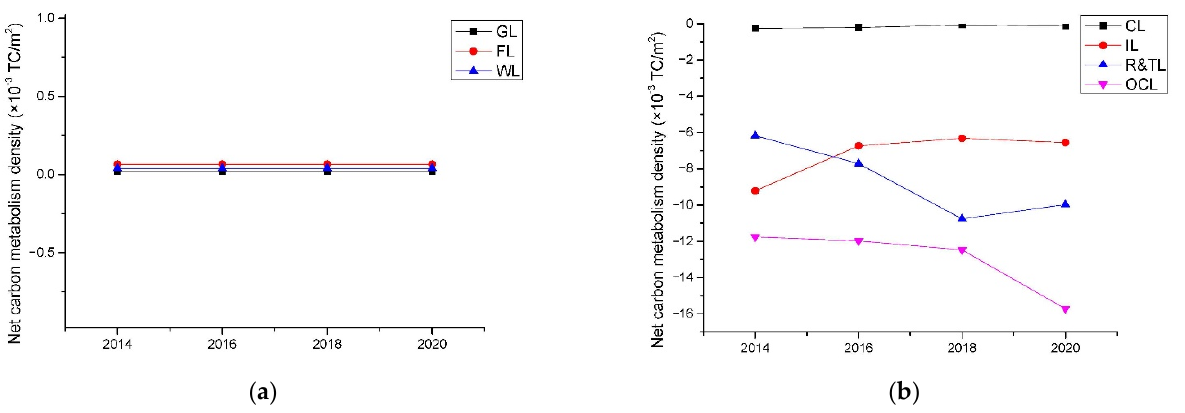
Figure 5. Carbon metabolism density. ( a ) Net carbon metabolism density of GL, FL, and WL; ( b ) net carbon metabolism density of CL, IL, R&TL, and OCL.